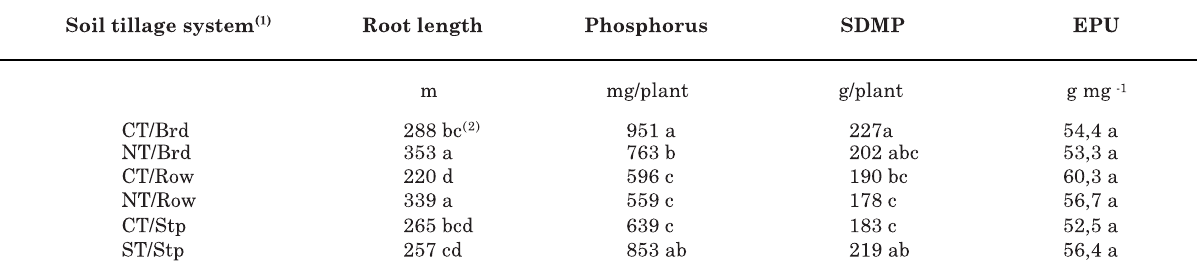
Table 2. Root length, phosphorus accumulation, shoot dry matter production (SDMP) and efficiency